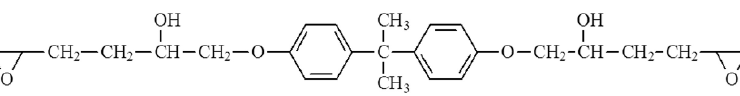
Figure 4. Deconvolution of C 1s XPS spectra of the CF surface: ( a ) untreated, ( b ) 12 A/240 s, ( c ) 16 A/240 s, ( d ) 20 A/240 s and ( e ) 24 A/240 s.